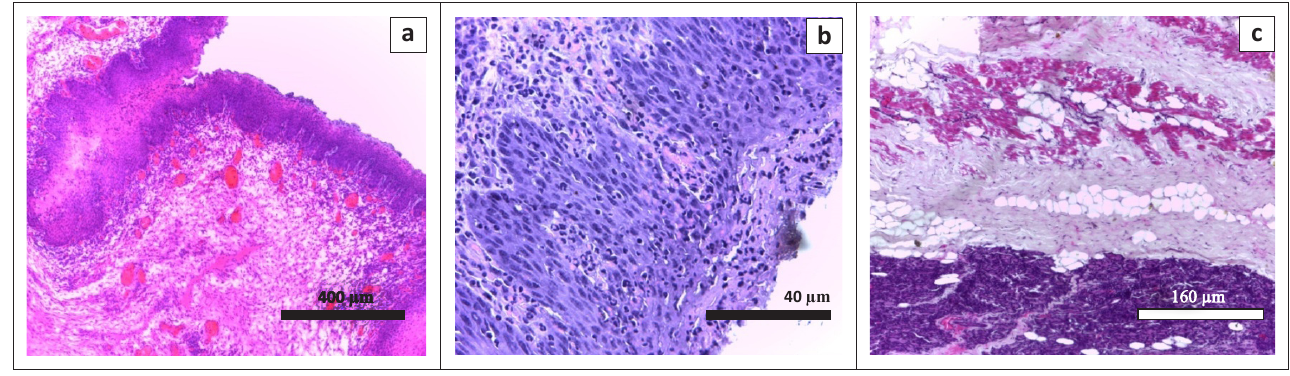
FIGURE 2: Photomicrograph of the eyeball of the ewe; (a and b) necrosis of the lining epithelium with suppurative conjunctivitis and (c) pressure atrophy of the tissues surrounding the cyst including lacrimal glands and muscular tissue: Haematoxylin and